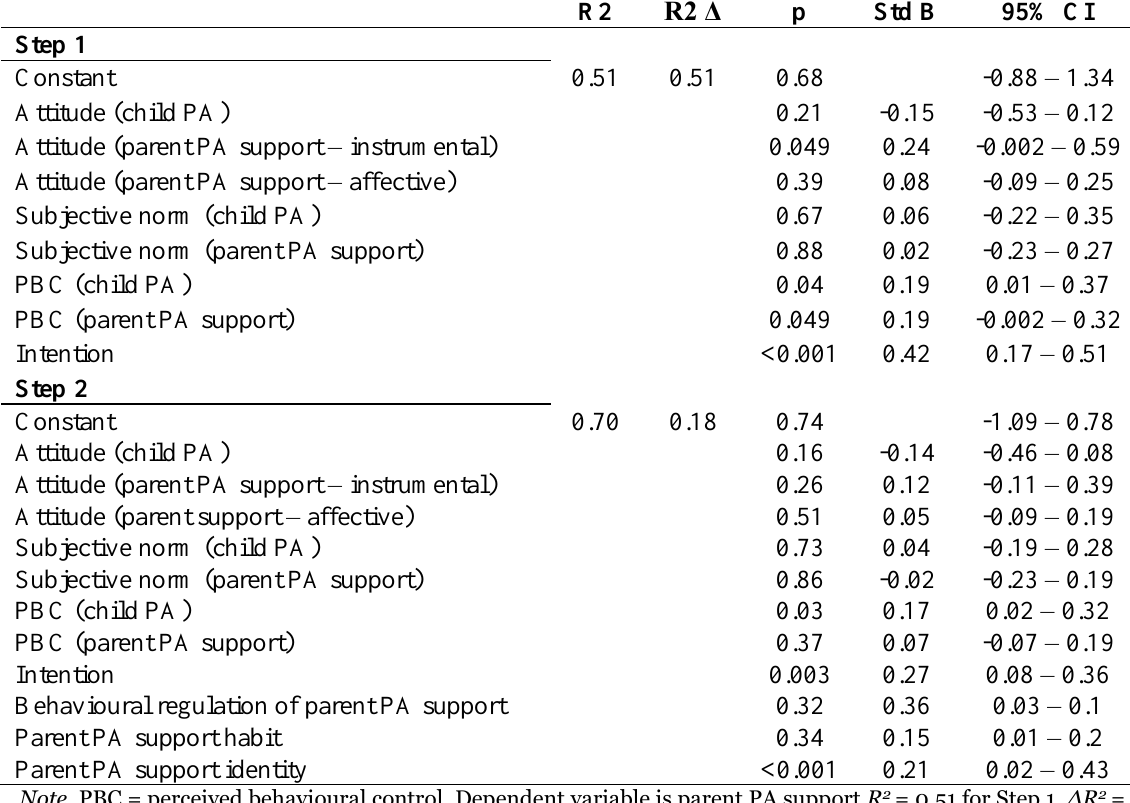
Table 4. Hierarchical regression results of theoretical predictors of parent PA